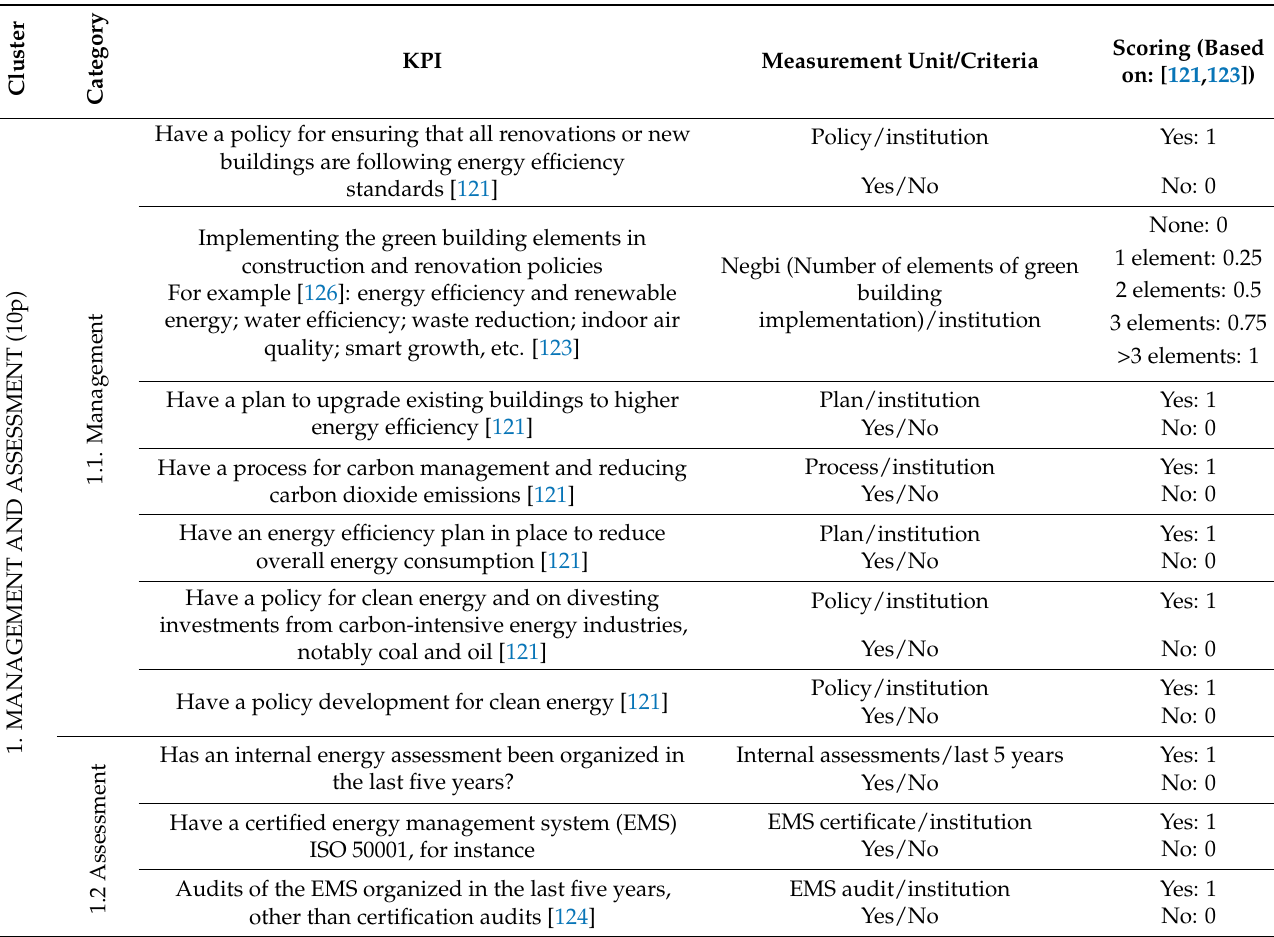
Table 1. KPIs for management and assessment of the